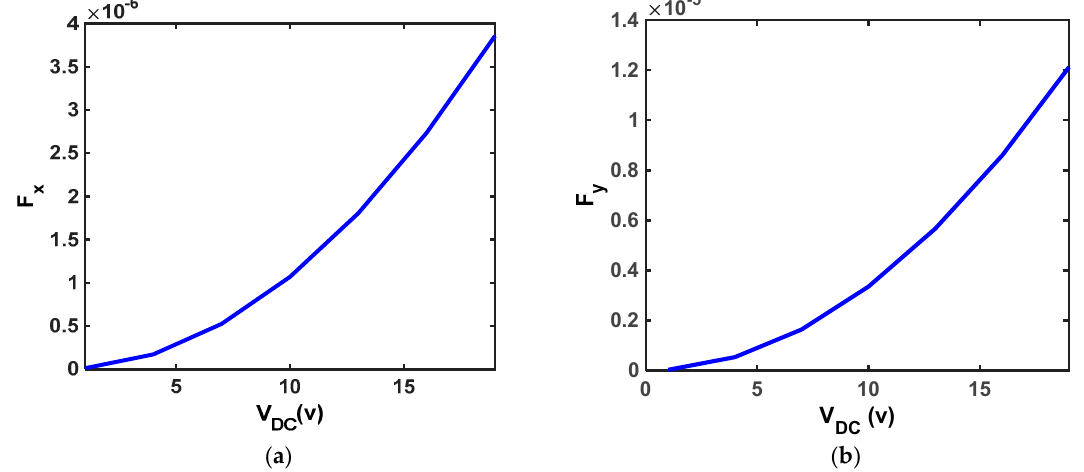
Figure 8. The relationship between the applied voltage and the force applied in the ( a ) x-direction and ( b ) y-direction to a graphene nanoribbon sheet (d = 25 nm). As expected, the relationship between the force and the applied voltage is a quadratic power law. This approach is correct based on the basics of physics, because the energy stored in the capacitor is (W = (1/2)CV 2 ).